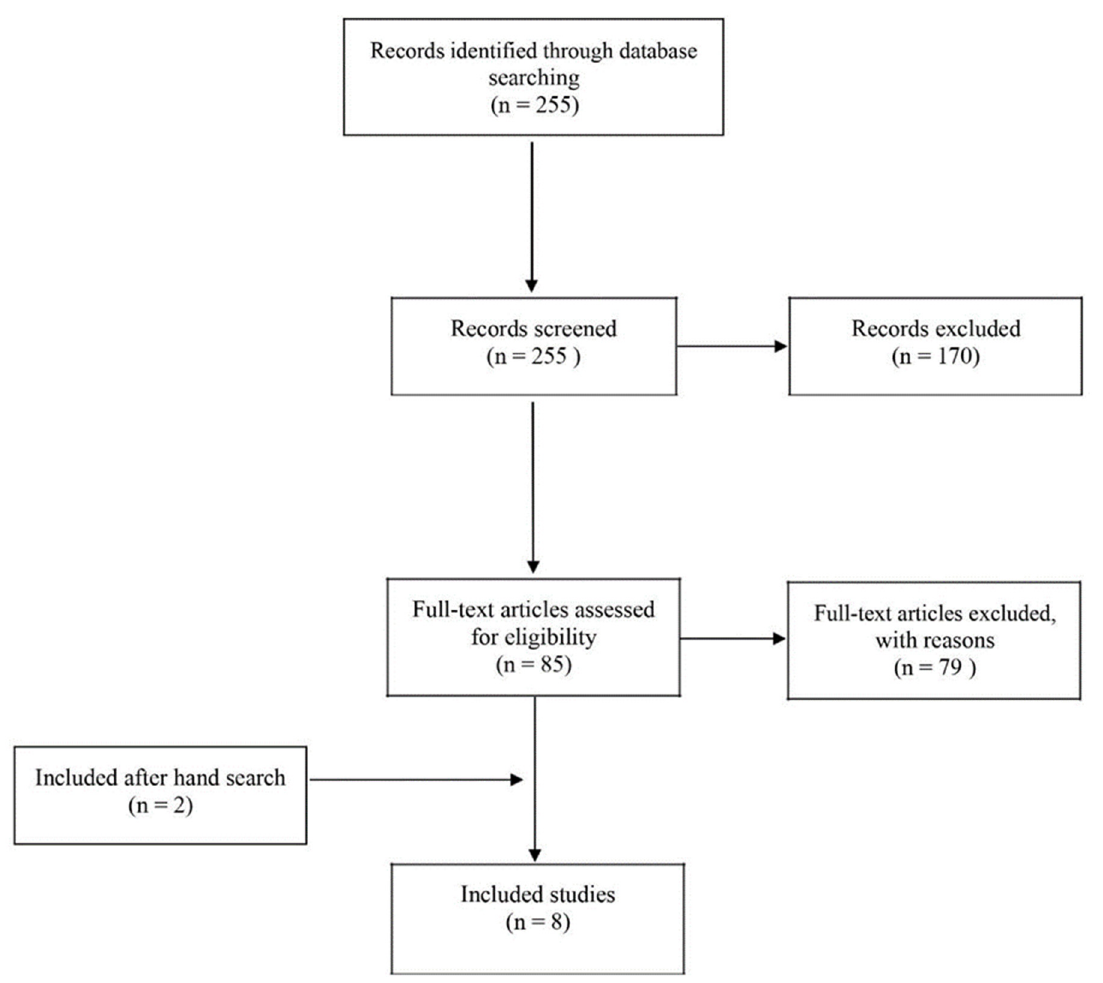
Figure 1. Flow chart of systematic review process.